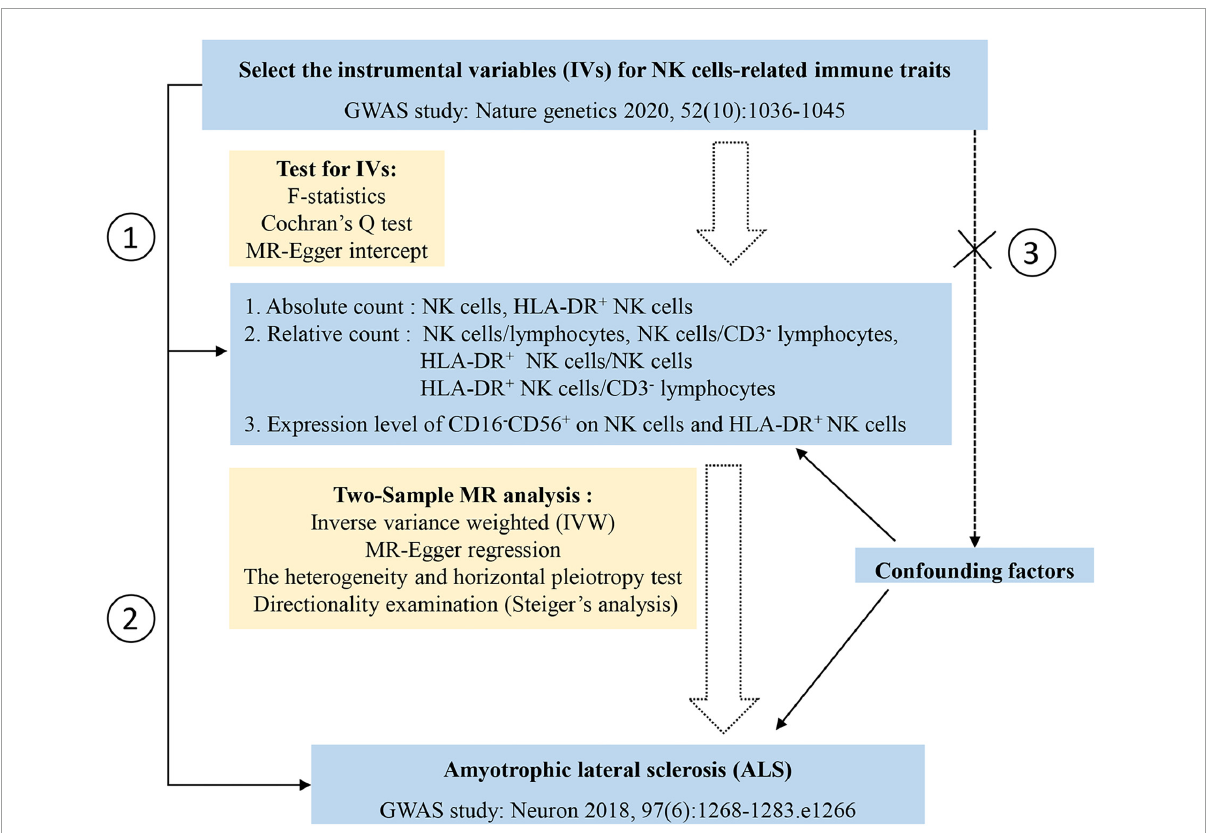
FIGURE1 Study design and the flow chart of statistical analysis. Three assumptions of the Mendelian randomization in the current study: assumption 1, the selected genetic variances, as instrumental variables, are associated with the risk factor, that is, natural killer (NK) cells-related immune traits in this case; assumption 2, the selected genetic variances are significantly associated with amyotrophic lateral sclerosis (ALS) through the risk factor only; assumption 3, the selected instrumental variables are not associated other confounding factors (the dashed line and cross symbol indicate no association between selected instrumental variables and confounding factors).